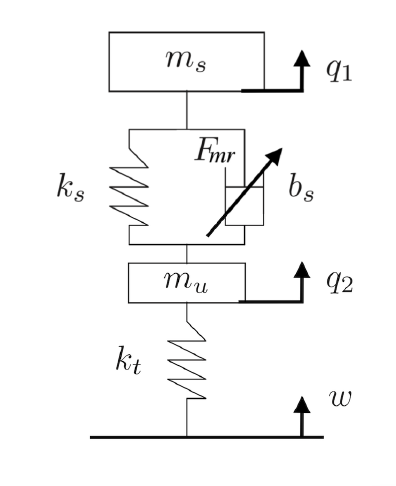
Figure 3. Quarter-car